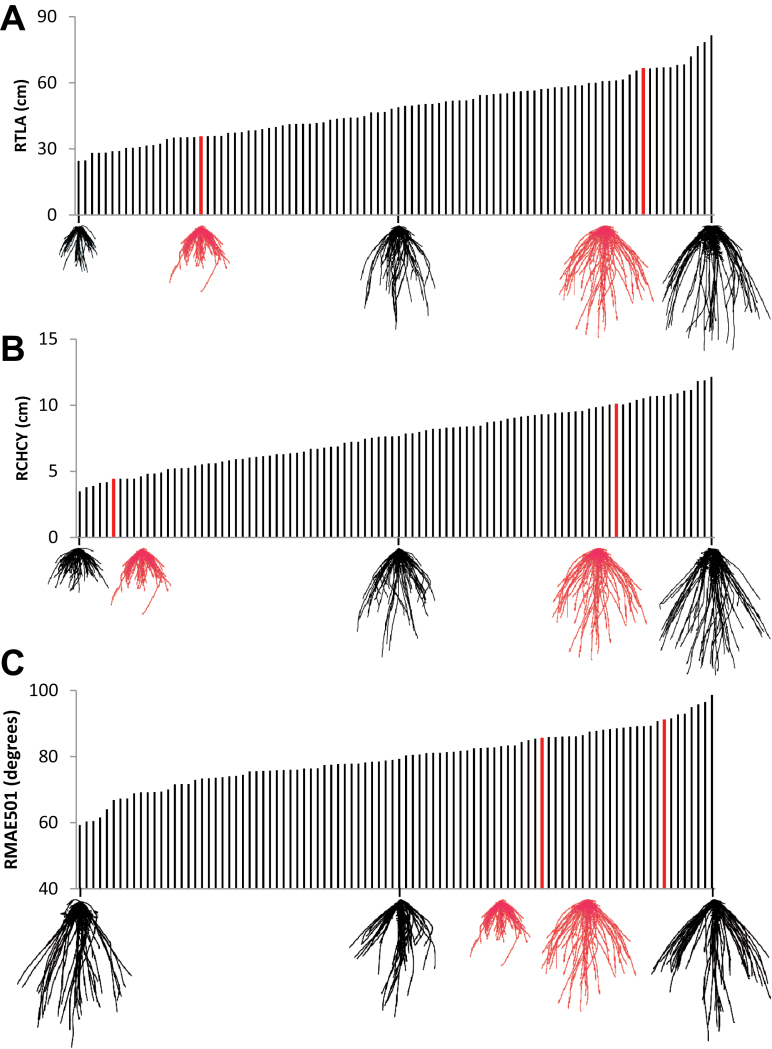
Phenotypic variation in RSA traits. Images are overlays of RSA images with parental lines shown in red (n = 18 for Savannah, right; n = 22 for Rialto, left). (A) Total root length. (B) y co-ordinate of convex hull centroid. (C) angle between outer pair of seminal roots at 50% seminal root length. For B-D, values are ordered by increasing value. Images are overlays of RSA images (n = 14 to 19) for the extreme and median values. The parental line values are shown in red.